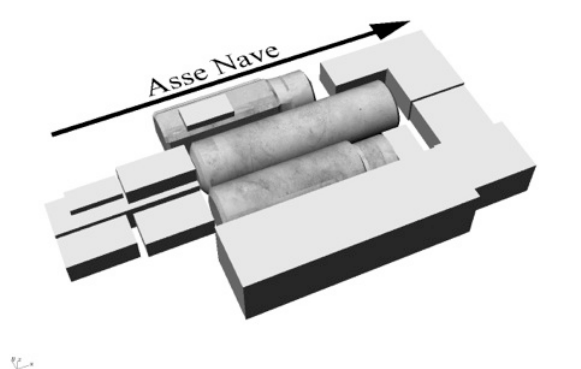
Figure 14. Marzamemi shipwreck. Reconstruction of the cargo in hypothetic stowage position. (Reconstruction: ing. S.